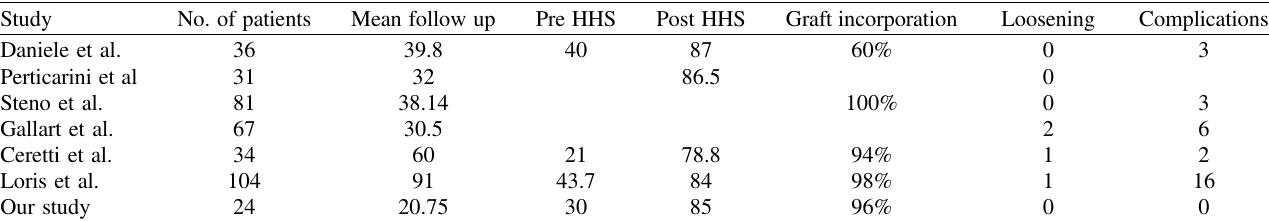
Table 4. Results of recent